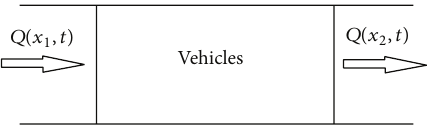
Figure 2: A segment of road is from 𝑥 1 to 𝑥 2 . The fractal flow in at the position 𝑥 1 is 𝑄(𝑥 1 , 𝑡) and the fractal flow out at the position 𝑥 2 is 𝑄(𝑥 2 ,𝑡)